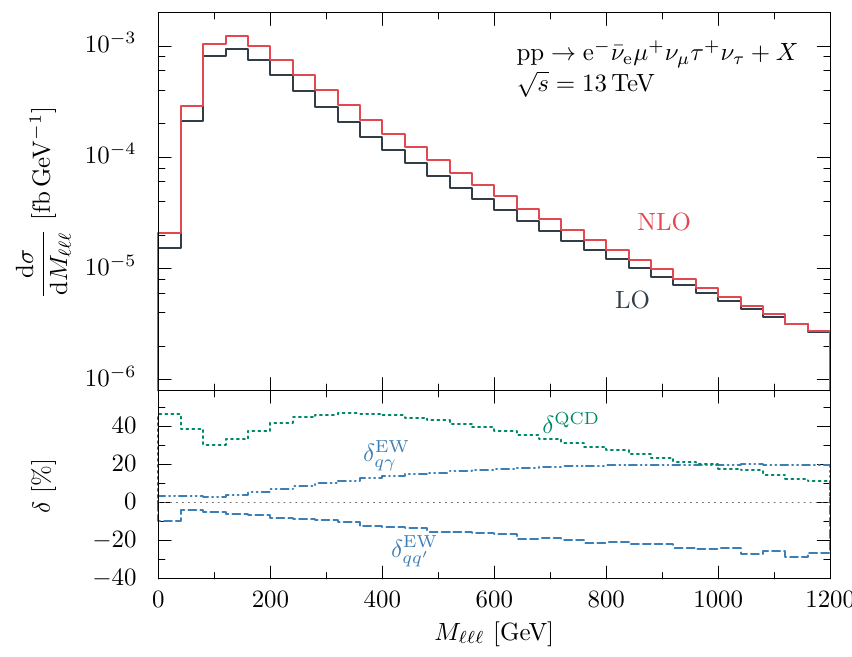
Figure 6. Di(cid:11)erential LO and NLO cross section, and relative NLO corrections in the invariant mass M ‘‘‘ of the three-lepton system. The upper part visualizes the dependence of the LO and NLO cross sections of M ‘‘‘ . The lower part shows the relative NLO